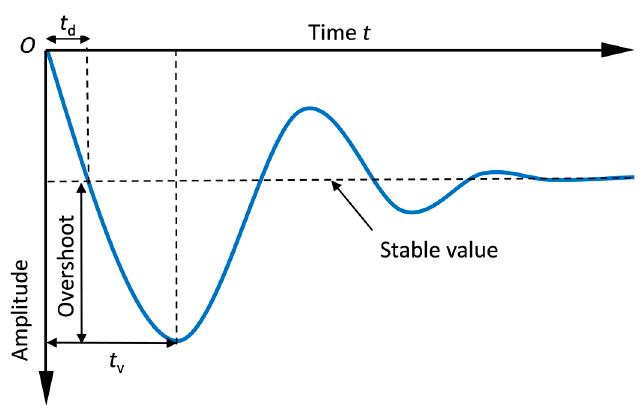
Figure 3. Performance of the step response for a second-order system (completely redrawn using the idea of [37] ).